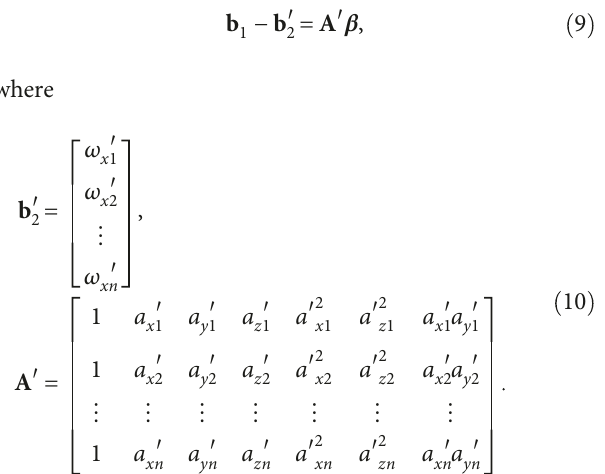
: the y z g 0 g 0 g 0 : the actual y z g g g